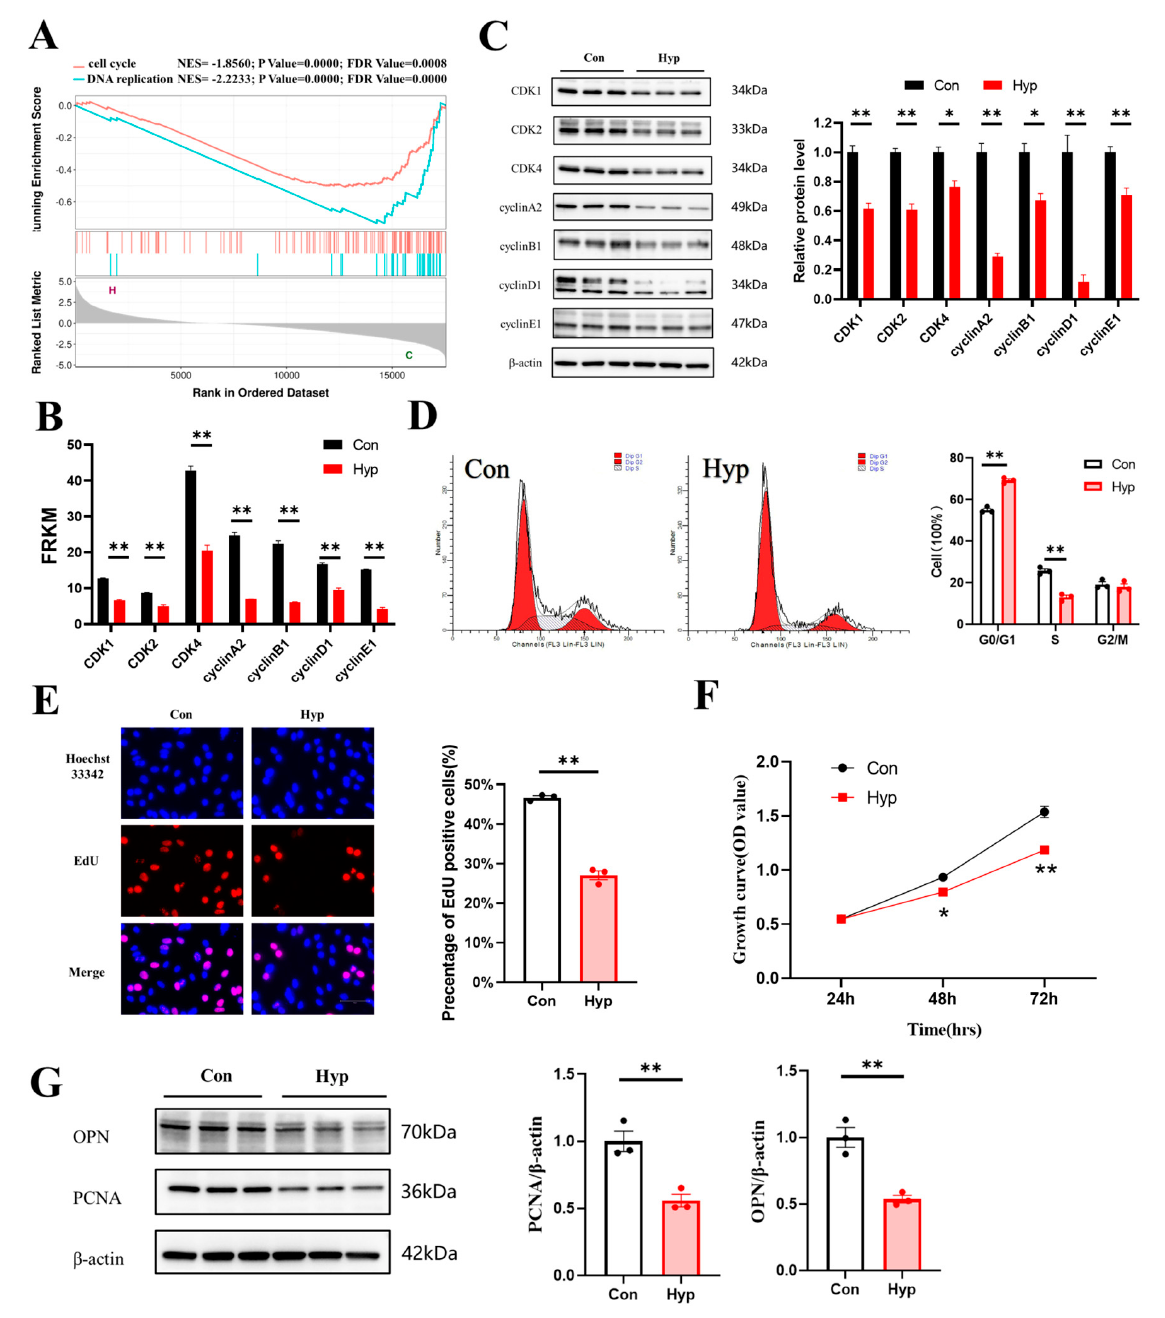
Figure 2. Hypoxia inhibits microvascular endothelial cell cycle progression and cell proliferation. ( A ) GSEA curves of differentially expressed genes for the hypoxia vs. control comparison. ( B ) The expression of cyclin − dependent kinase 1( Cdk1) , Cdk2 , Cdk4 , cyclin A2 , cyclin B1 , cyclin D1 , and cyclin E1 from RNA − seq data. ( C ) Western blot analysis of CDK1, CDK2, CDK4, cyclin A2, cyclin B1, cyclin D1, and cyclin E1 ( n = 3). ( D ) The percentages of cells in the G0/G1, S, and G2/M phases of the cell cycle were quantified by flow cytometry ( n = 3). ( E ) The EdU (red) assay was used to examine cell proliferation ( n = 3). EVOS M5000 objective magnification: 40×. ( F ) Cell proliferation was evaluated by a CCK − 8 assay ( n = 3). ( G ) Proliferating cell nuclear antigen (PCNA) and osteopontin (OPN) expression was determined by Western blotting ( n = 3). Data are shown as the mean ± SEM, * p < 0.05, ** p < 0.01. Hyp indicates hypoxia, and Con indicates